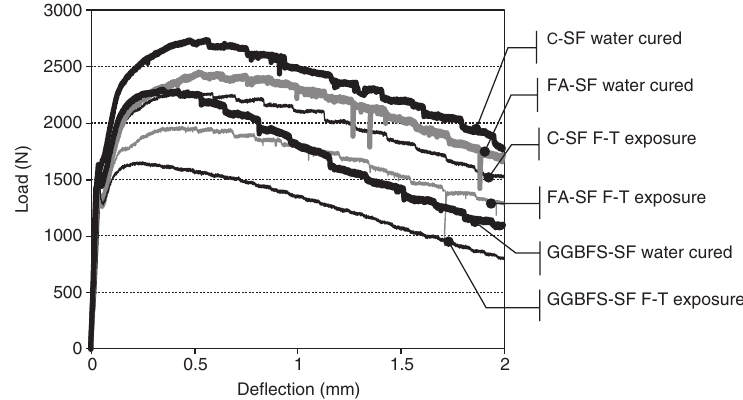
Figure 5 Flexural load-deflection curves of fibered SCRM series.